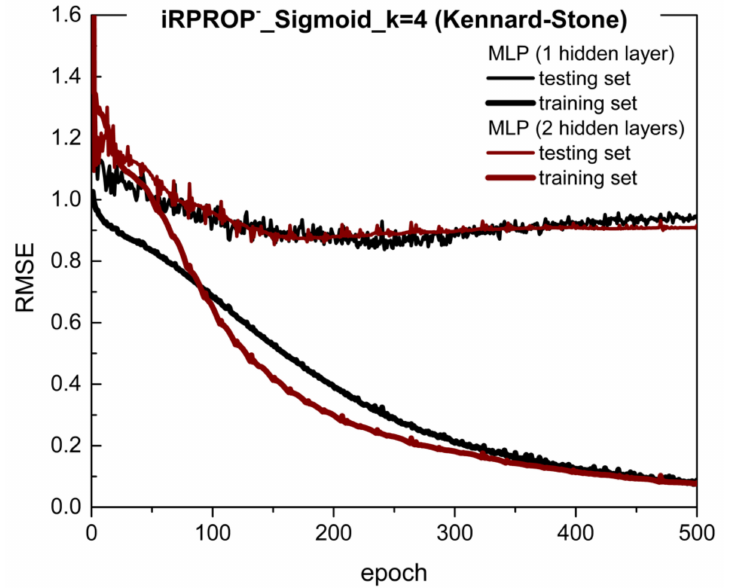
Figure 6. RMSE values as a function of epoch in training and testing sets for iRPROP − -based learning MLP with one and two hidden layers ( Sigmoid activation function, Kennard–Stone-based train–test splitting),